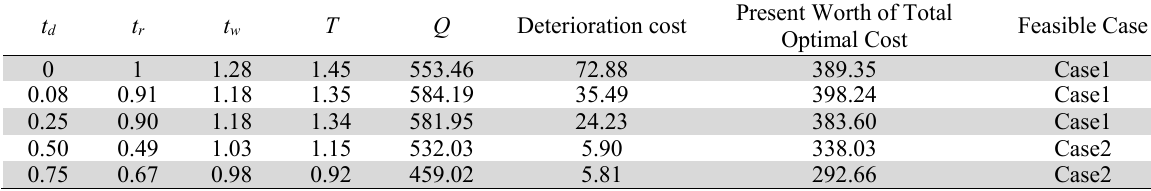
Effect of non deteriorating period ( t d ) on optimal solution